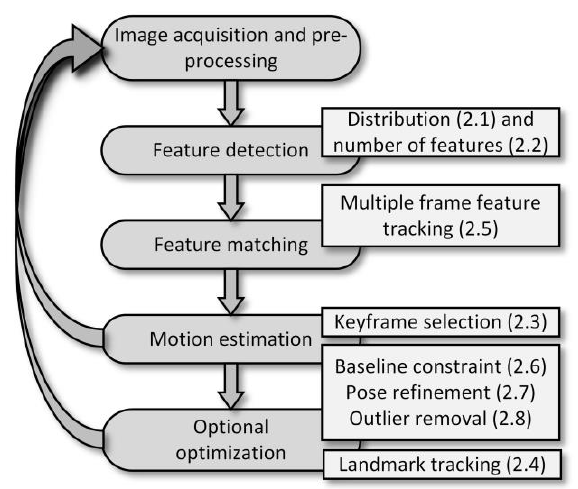
Figure 1. General VO workflow and the relation to enhance- ment strategies as discussed in section